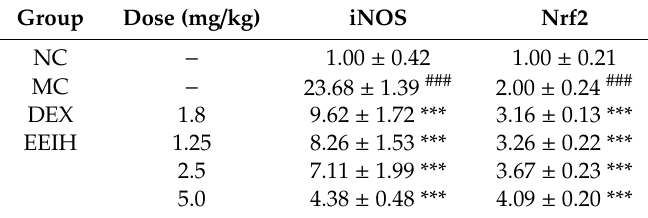
Table 7. E ff ects of EEIH on the mRNA expression levels of inducible nitric oxide synthase (iNOS)